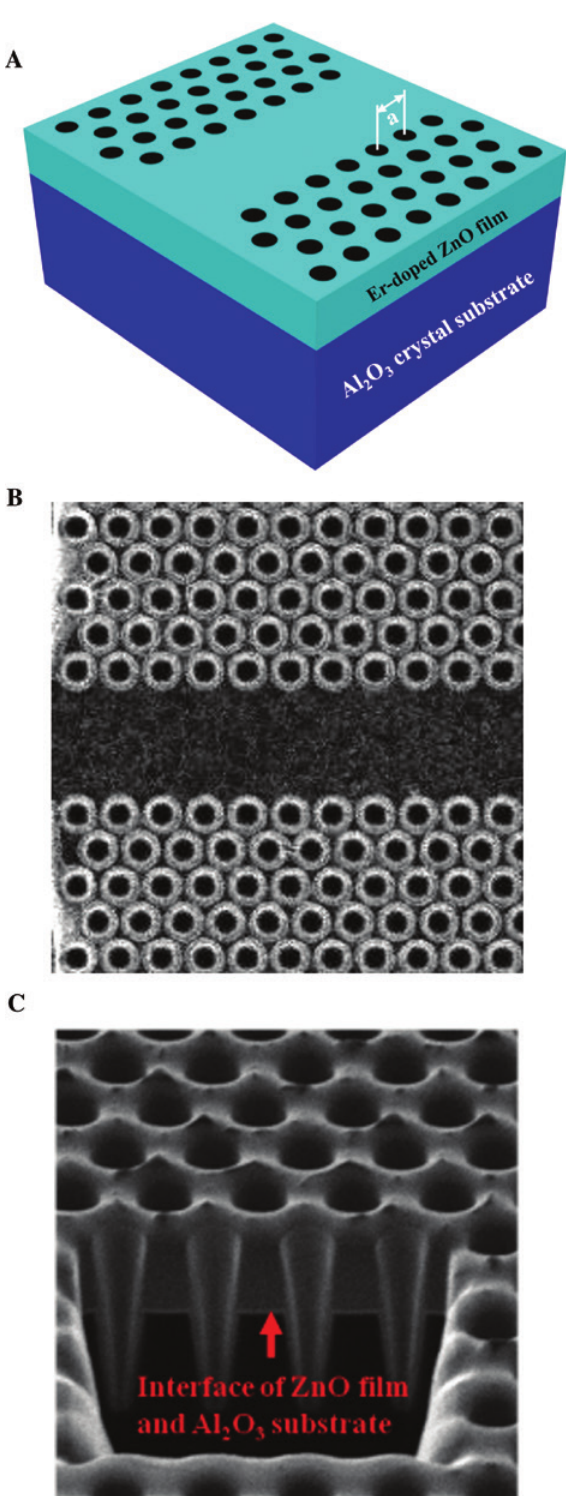
Figure 5: (A) Schematic diagram of the PC structure on the film, a core Er:ZnO layer (green) is deposited on Al a is the lattice constant. (B) The SEM image of the PC with hexagonal lattice of air holes fabricated by FIB etching. The lattice constant and diameter of holes are set to be 597 nm and 149 nm, respectively. (C) The cross-section of the air holes.